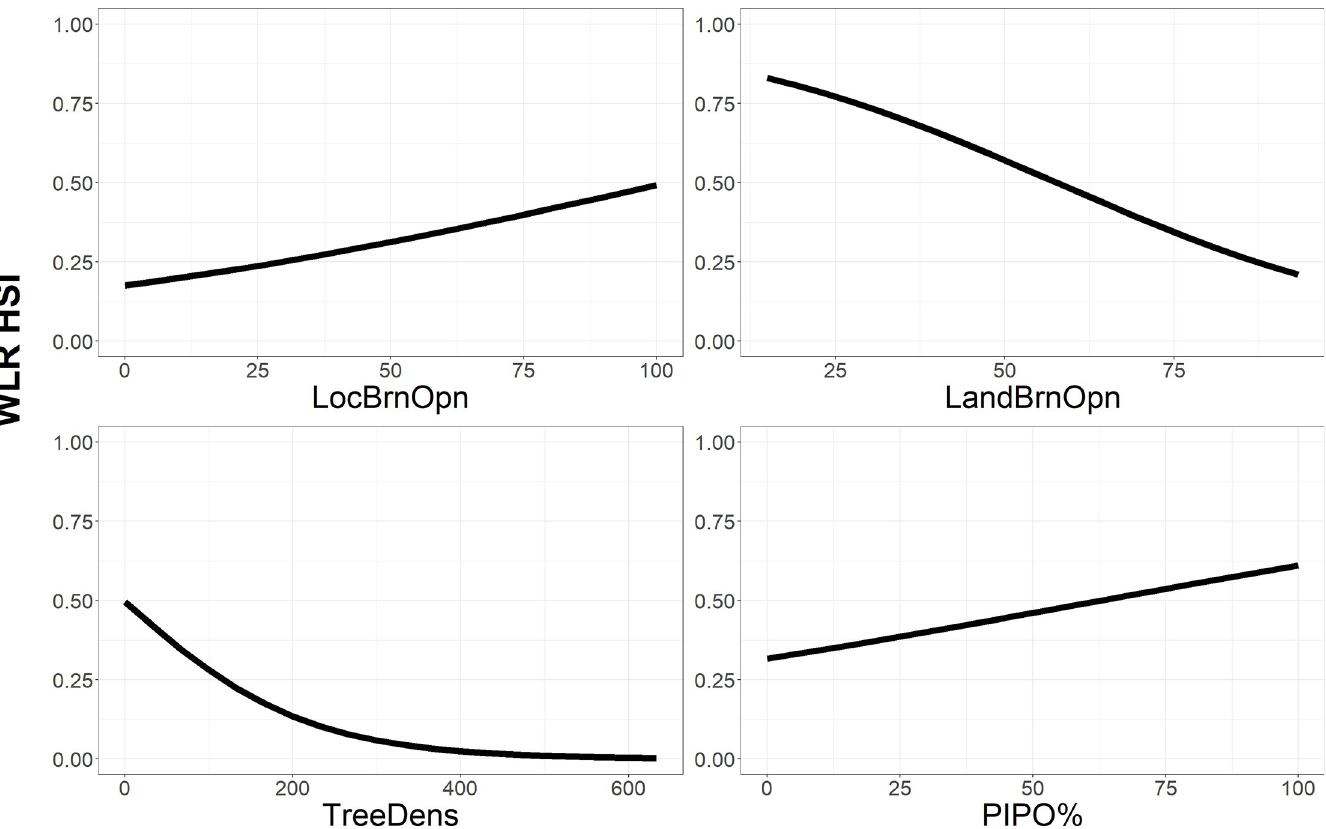
Fig 3. Weighted logistic regression (WLR) HSI relationships with underlying covariates. Covariates are local- and landscape-scale percent area burned or open (LocBrnOpn, LandBrnOpn), density of live trees (TreeDens), and percent ponderosa pine (PIPO%). Complete descriptions are in Table 2. The model represented pooled data across Toolbox and Canyon Creek wildfire locations (Oregon).